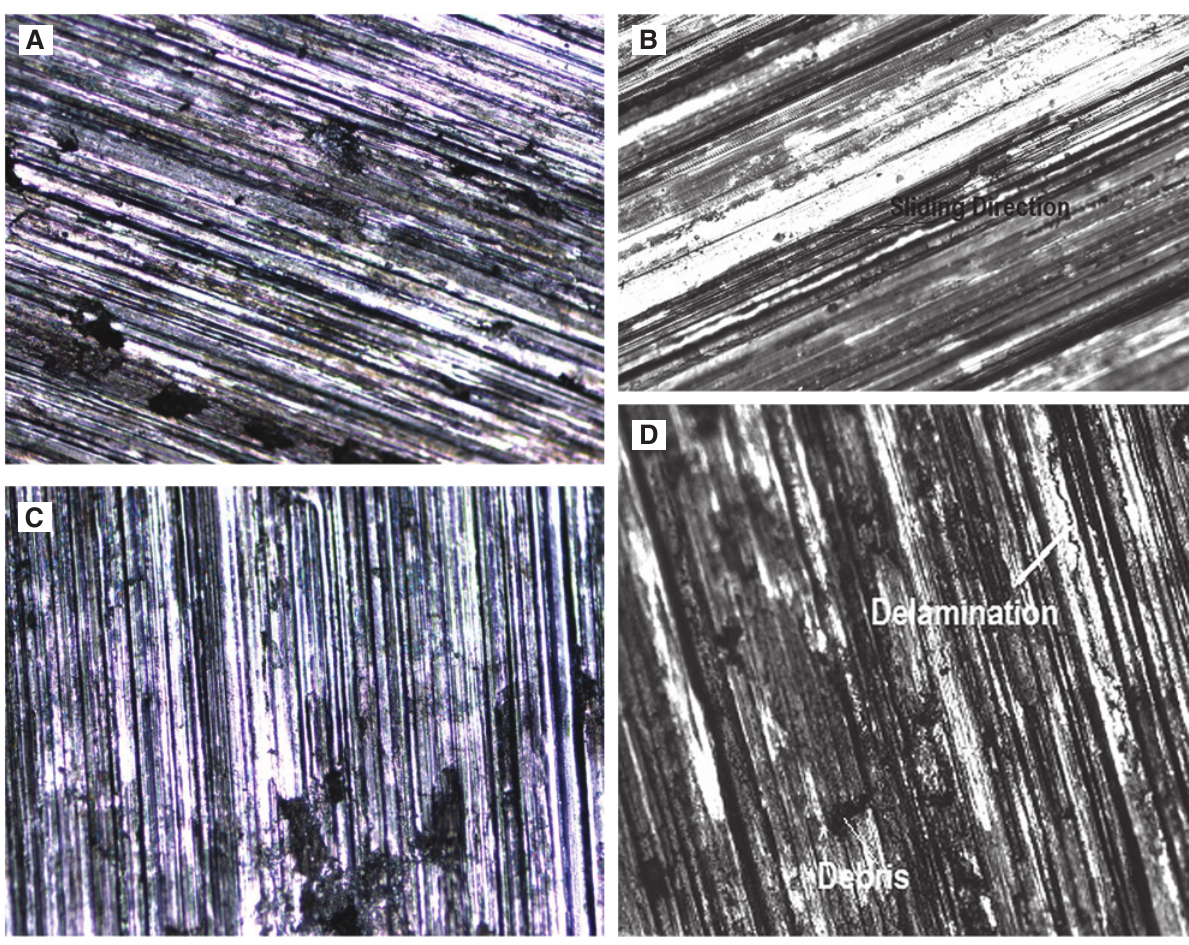
Figure 13: Micrographs of (A) worn surface for 5% at 20 N load; (B) worn surface for 5% at 30 N load; (C) worn surface for 7% at 20 N load; and (D) worn surface for 7% at 30 N